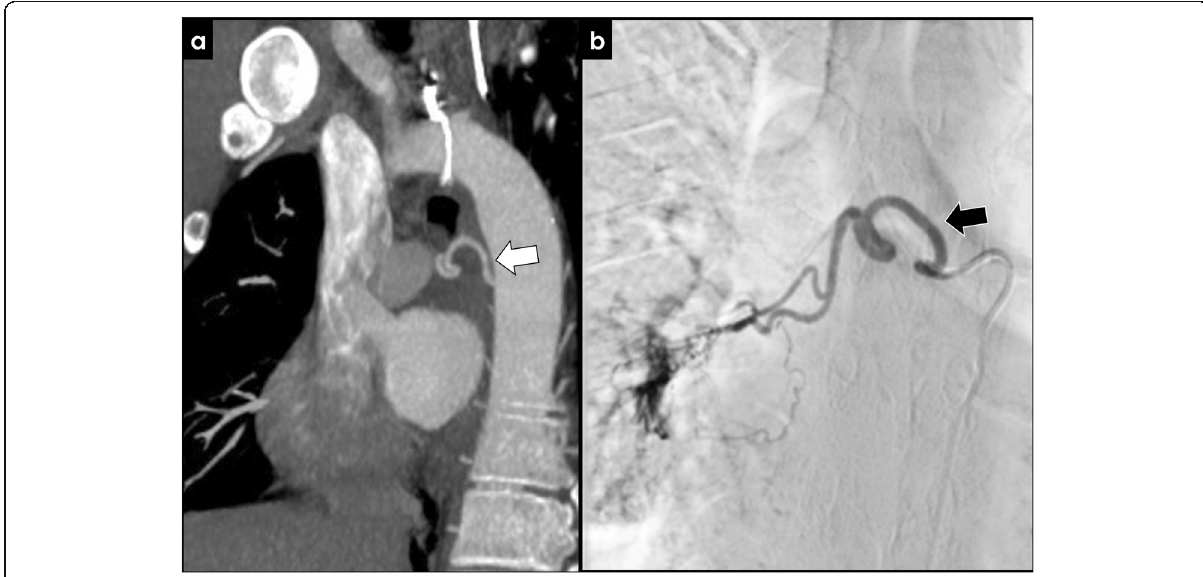
Fig. 11 Bronchial artery hypertrophy. Imaging findings of bronchial artery hypertrophy with CECT ( a , white arrow) and angiography ( b , black arrow). Hypervascularity and bronchial artery-pulmonary artery shunt are usually well illustrated with angiography ( b